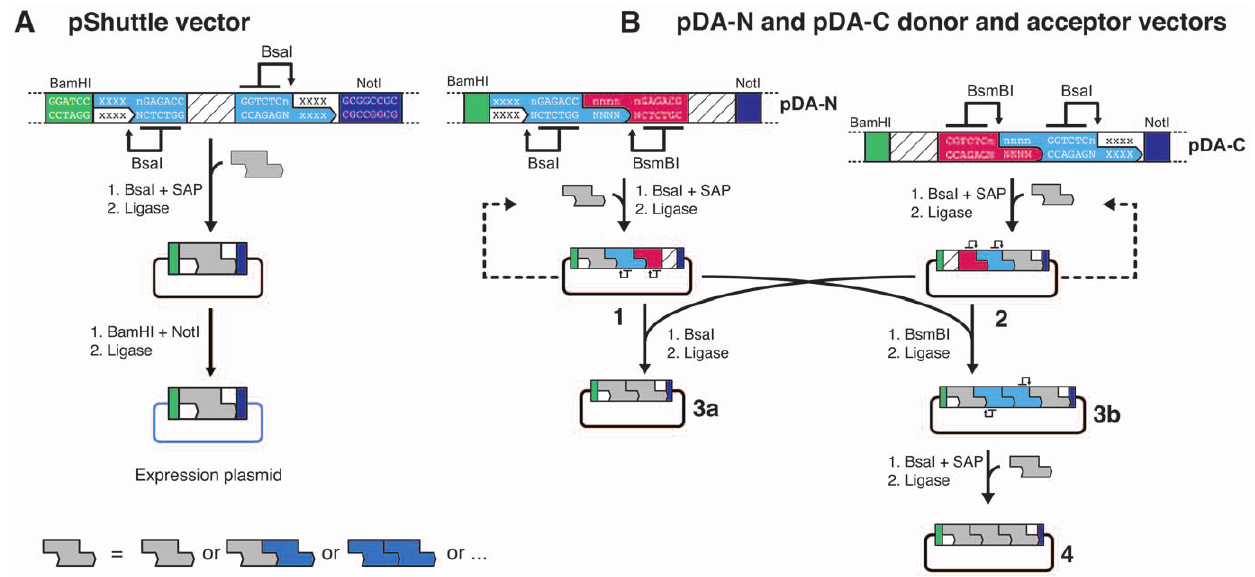
Figure 2. Vectors for synthon recombination and transfer to expression plasmids. (A) Deprotected synthons can be ligated into a BsaI- digested shuttle vector (pShuttle) that contains 5 9 -BamHI and 3 9 -NotI restriction sites compatible with our in-house collection of expression vectors. (B) For applications that require modular recombination or insertion of individual elements, synthons can be ligated into the modular assembly vectors pDA-N or pDA-C. pDA-N vectors that carry synthons encoding amino-terminal elements of protein constructs ( 1 ) can be combined with synthons encoding carboxyl-terminal elements from pDA-C vectors ( 2 ) to yield a composite product ( 3a ), optionally leaving an additional entry point via BsaI restriction sites to insert additional synthons ( 3b ). Final assemblies ( 3a and 4 ) contain 5 9 -BamHI and 3 9 -NotI restriction sites for transfer into expression vectors.